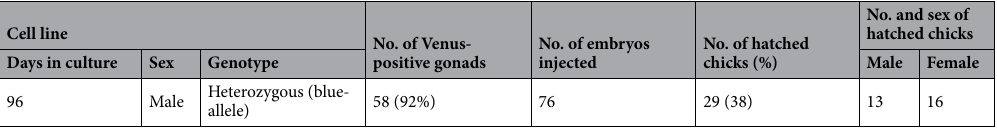
Table 2. Migration efficiency of Venus-positive PGCs.